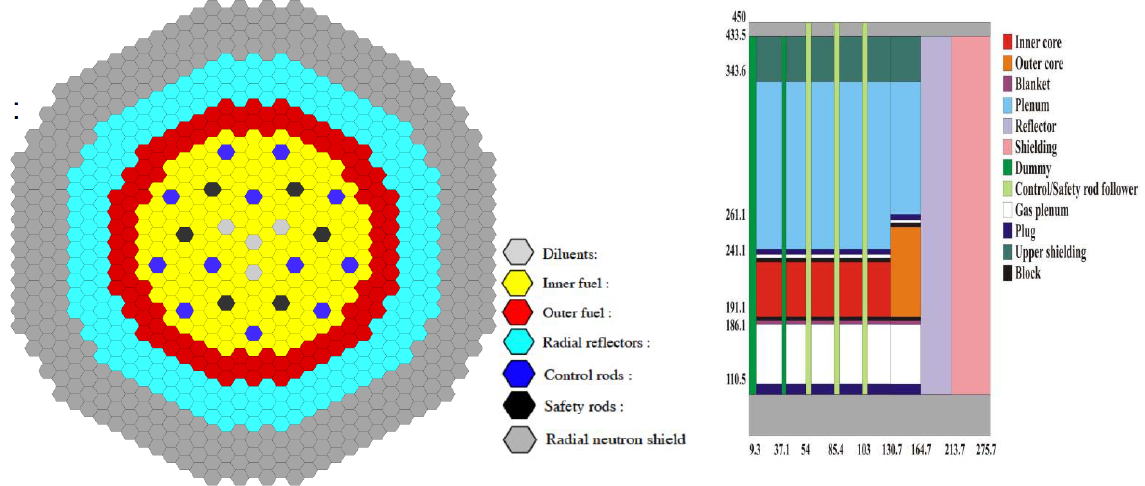
Figure 5. Radial (left) and axial (right) layout of the ASTRID core design. Pictures taken from [12].